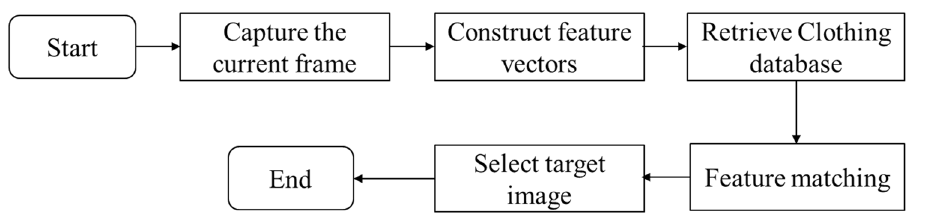
Figure 6. Clothing image matching